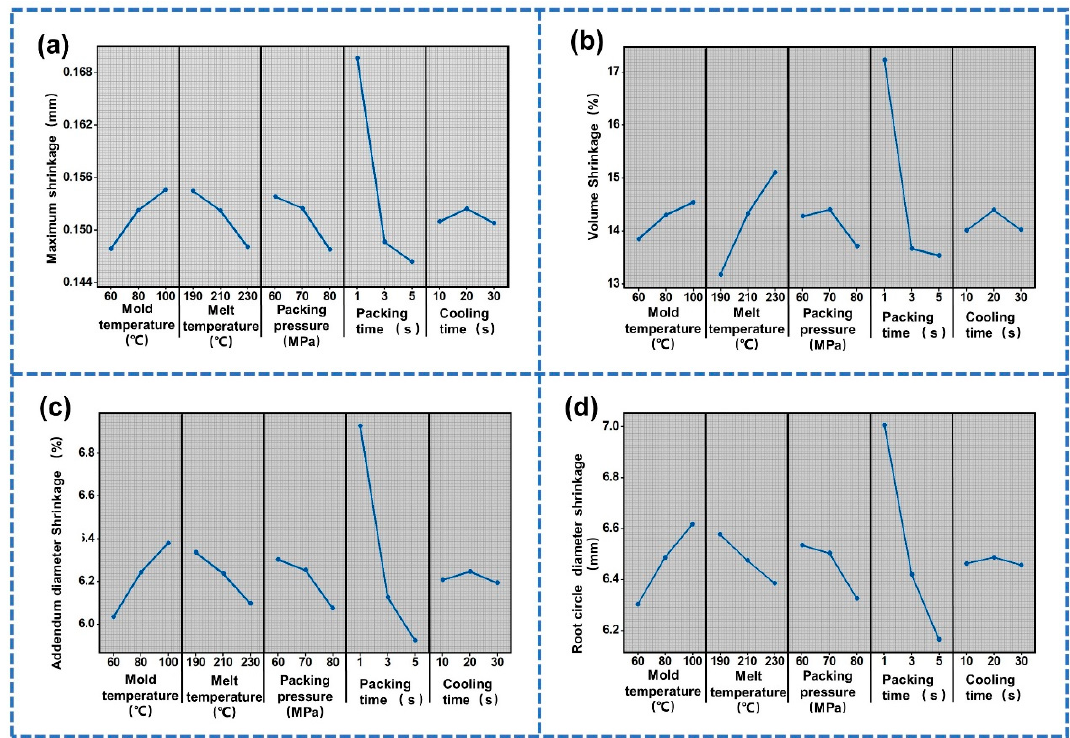
Figure 10. Main effect diagram: ( a ) Maximum shrinkage ( Y 1 ). ( b ) Volume shrinkage ( Y 2 ). ( c ) Addendum diameter shrinkage ( Y 3 ). ( d ) Root circle diameter shrinkage ( Y 4 ). Table 9. ANOVA for maximum shrinkage. Table 9 is the variance analysis table of the maximum shrinkage in which the contribu-